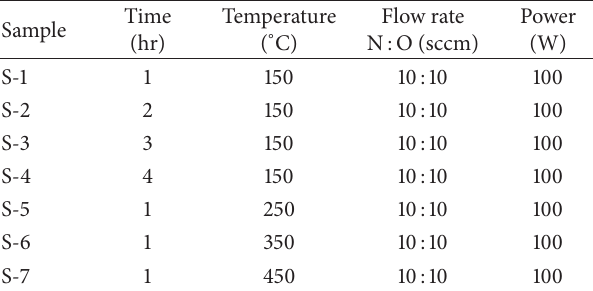
Table 1: The deposition condition of Al-doped CdO thin films. Sample